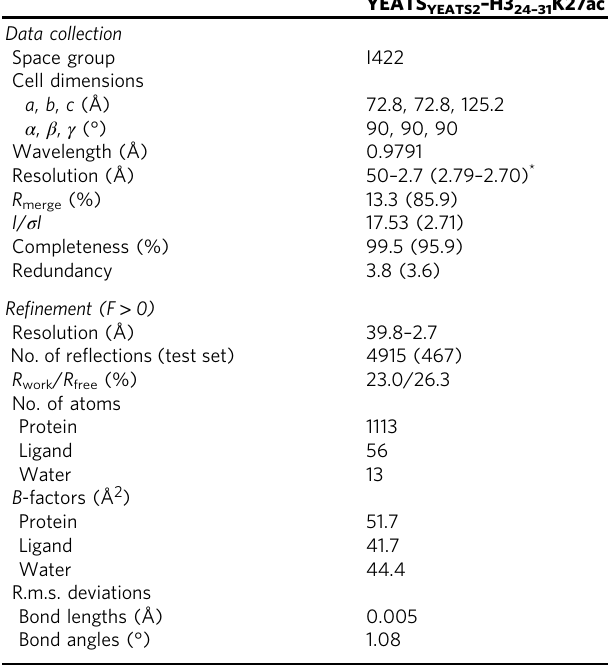
Table 1 Data collection and re fi nement